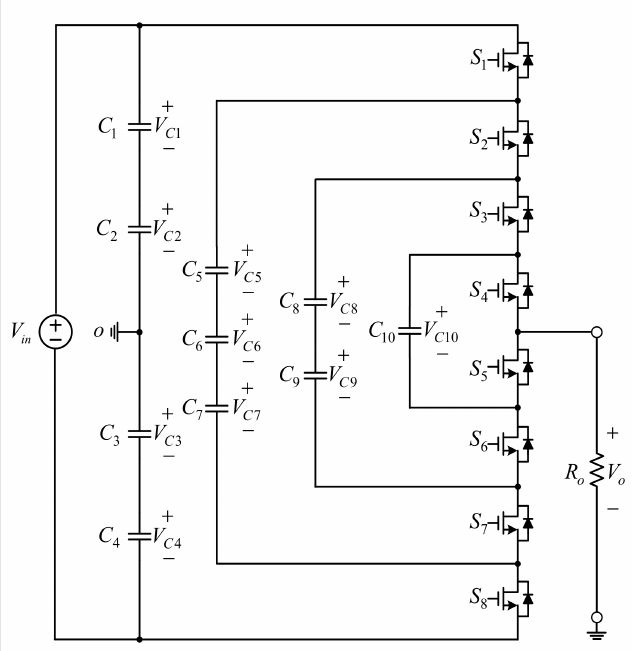
Figure 6. Circuit structure of a five-level flywheel capacitor inverter. Status I [ V o = 0]: When the switches S 1 , S 4 , S 6 , and S 7 are on, and switches S 2 , S 3 , S 5